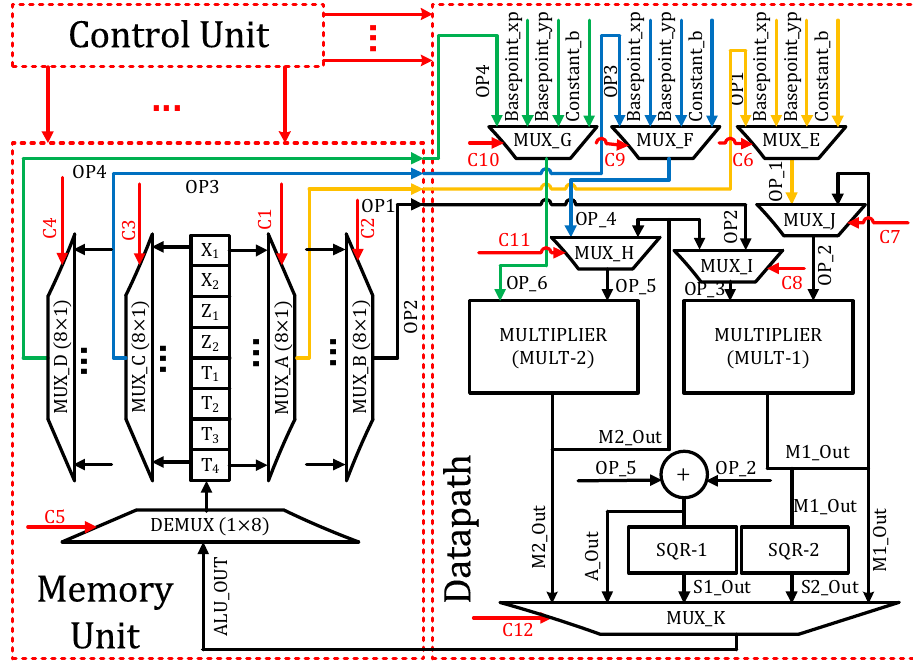
Figure 2. Proposed high-speed elliptic-curve point multiplication